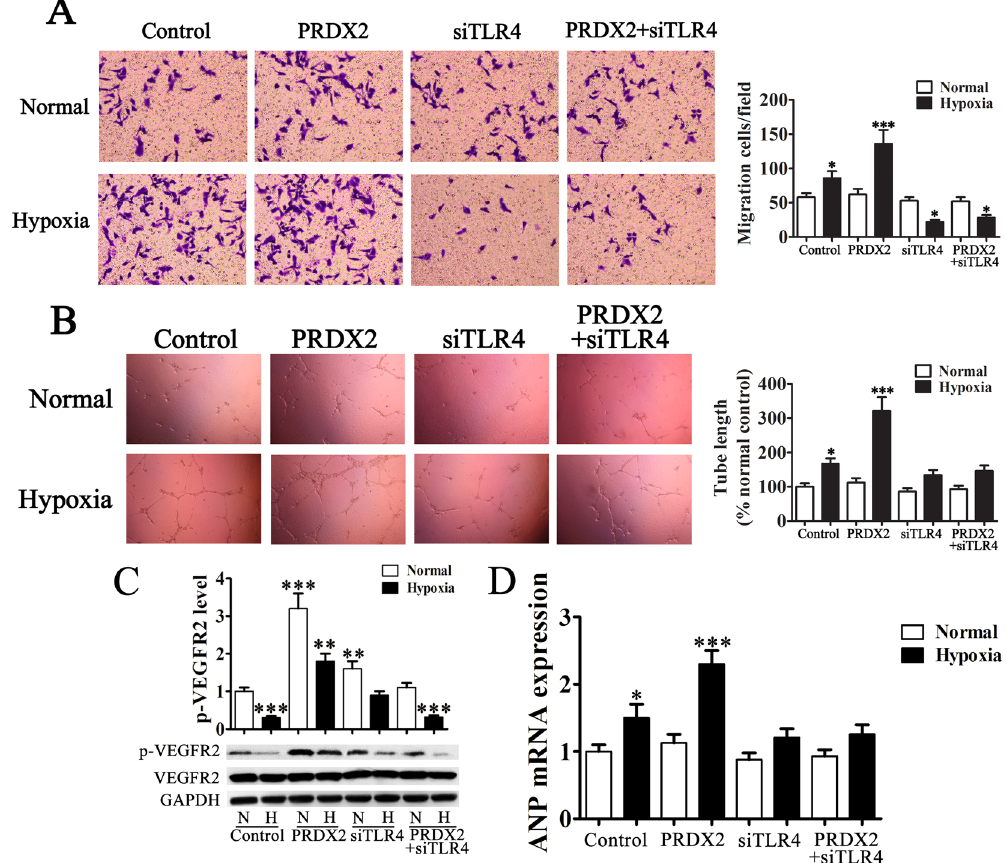
Figure 4. PRDX2 overexpression in H9c2 cells promote HUVEC migration, vasculogenic mimicry formation and myocardial hypertrophy related protein expression. H9c2 cells were cultured in serum-free medium and exposed to hypoxic conditions for 6 h then in normal conditions for another 24 h, then the medium was harvested for transwell and vasculogenic mimicry formation of HUVECs. ( A ) Migration of HUVECs was assessed using transwell chambers. The invasive capabilities of HUVECs are significantly increased with chemotaxis of PRDX2 overexpression in H9c2 cells. The data are presented as means ± SD of the mean from ten separate cell experiments. * p < 0.05, ** p < 0.01, *** p < 0.001 vs control. ( B ) Images of tube formation. Tube length is presented as percent of total tube length per field versus untreated control cells. The data are presented as means ± SD of the mean from ten separate cell experiments. * p < 0.05, ** p < 0.01, *** p < 0.001 vs control. ( C ) VEGFR2 phosphorylation in the surface of HUVECs was detected by western blots. The phospho-specific bands were quantified and normalized by the intensities of the corresponding VEGFR2 bands. The data are presented as means ± SD of the mean from three separate cell experiments. * p < 0.05, ** p < 0.01, *** p < 0.001 vs control. ( D ) RT-PCR analysis of ANP expression. The data are presented as means ± SD from three separate cell experiments. * p < 0.05, ** p < 0.01, *** p < 0.001 vs